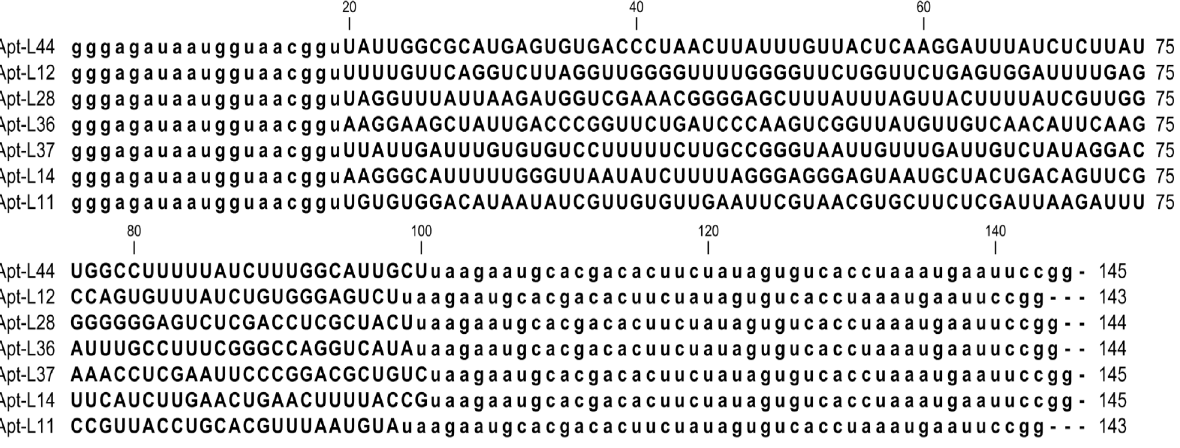
PLOS Neglected Tropical Diseases |